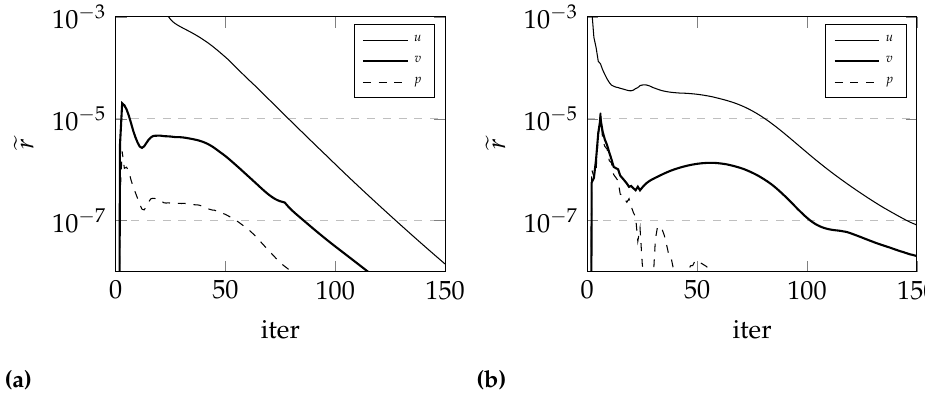
25 and (b) 545 385 25 and ( b ) 545 × × × ×